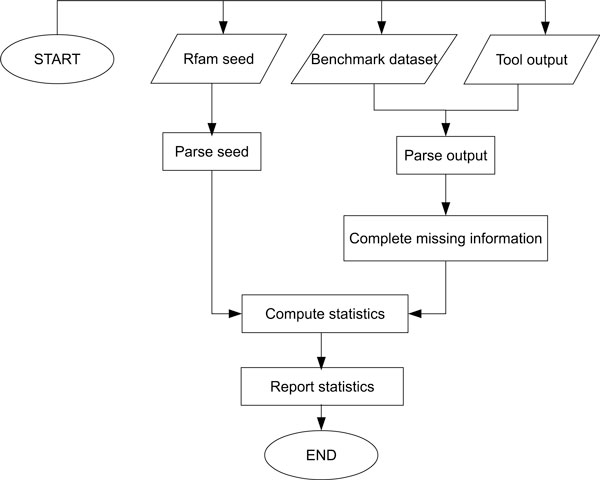
Measurement tool.